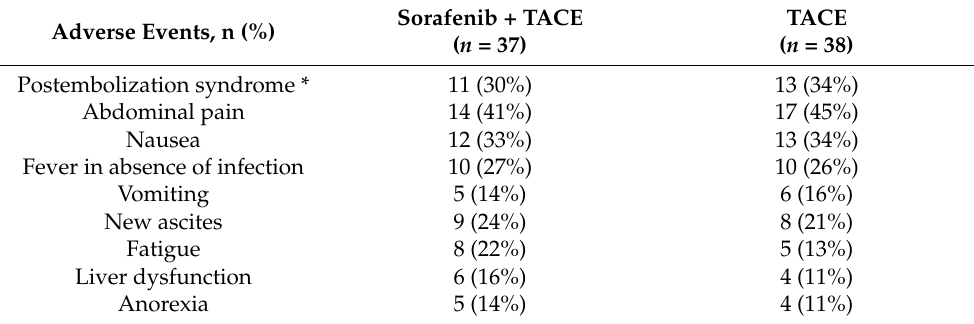
Table 6. Adverse events related to TACE occurring in ≥ 10% of the